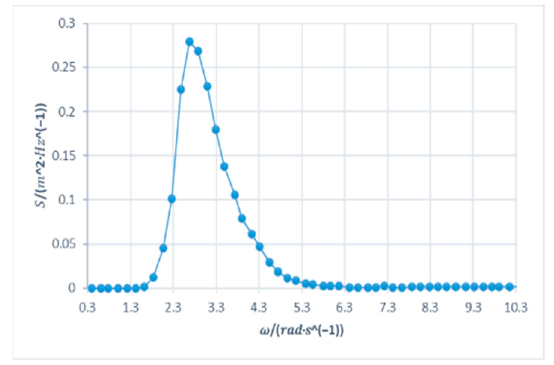
Figure 5. JONSWAP spectrum at Hs = 0.7 m, Tz = 4.55 s.